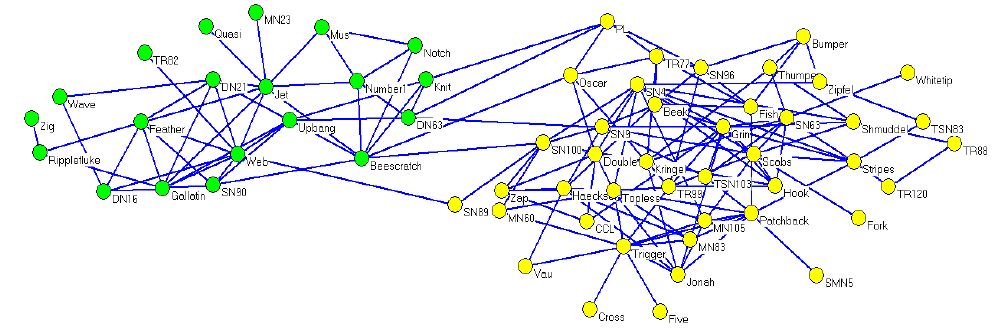
Figure 6. (Color online) Detected communities on the dolphin social network (when λ = 0.41, NMI = 1).